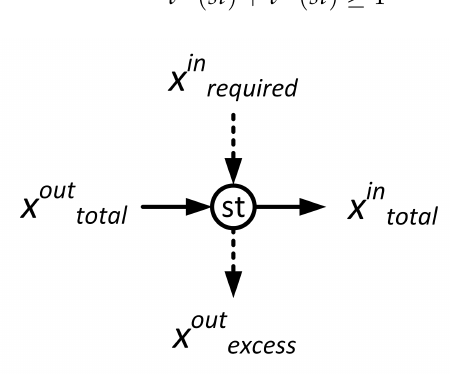
Figure 4. Representation of a generic compound node st : x out ( st ) indicates all st consumed by the technologies; x in technologies; x in total of st that needs to be purchased from the market; x out excess ( st ) indicates the amount of st that is produced in excess of the technologies